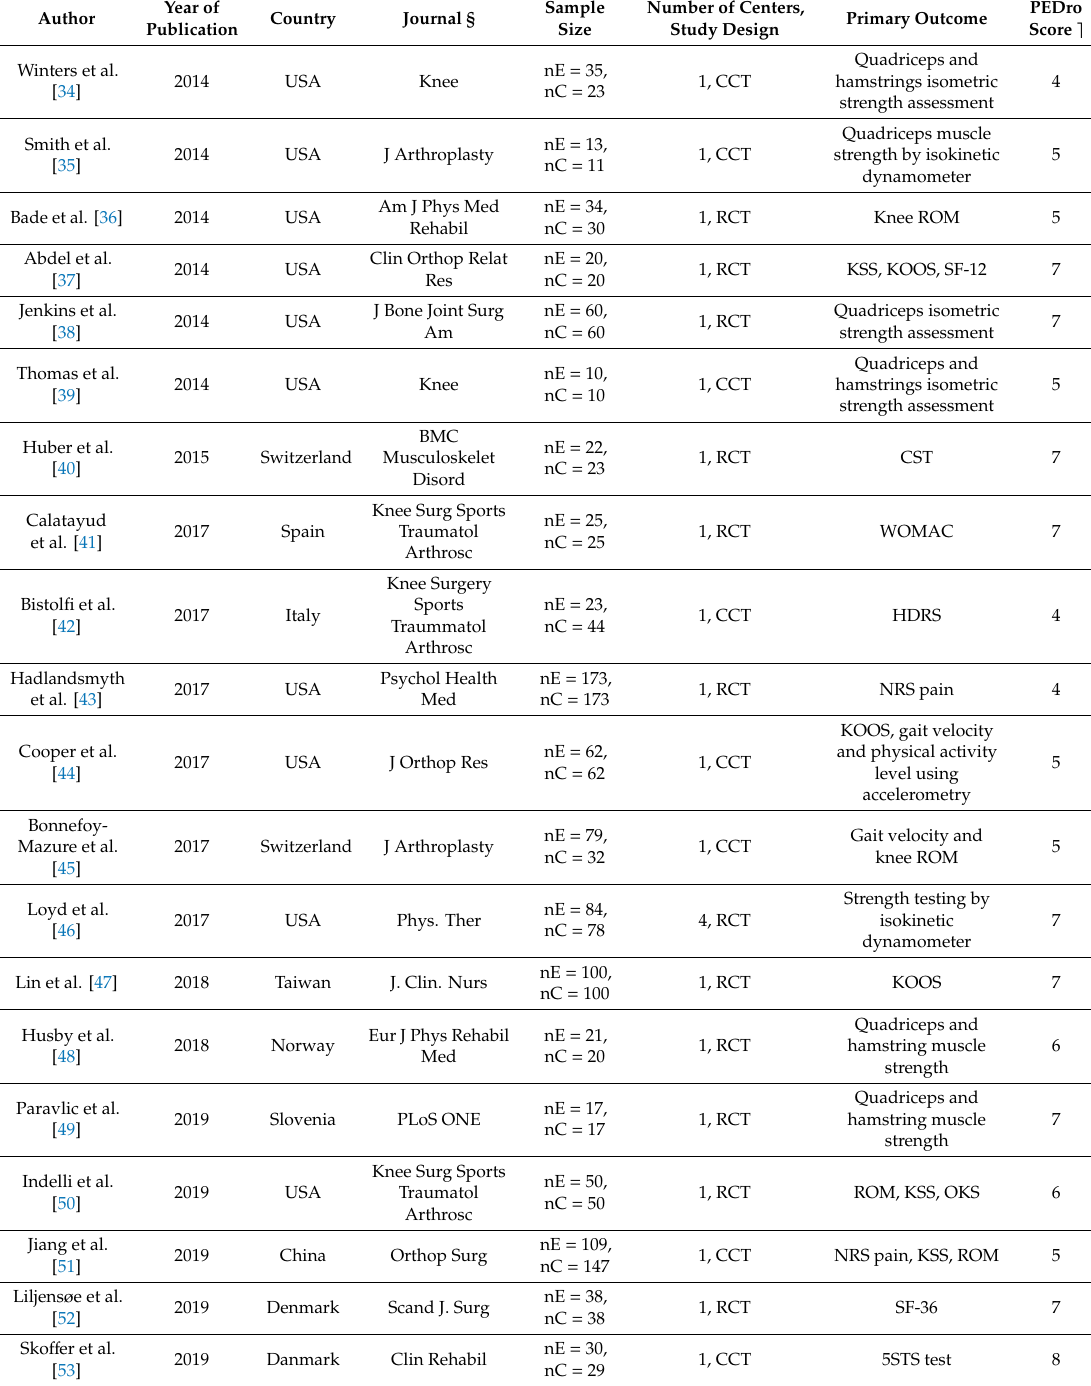
Table 1. Articles included in the